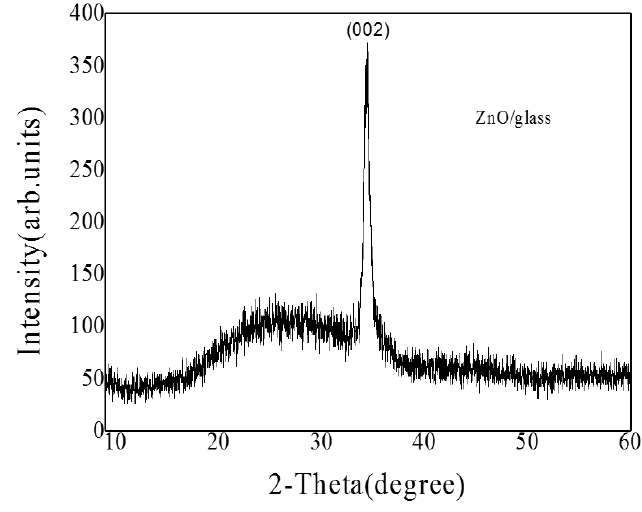
Figure 4. The XRD patterns of ZnO/glass films.